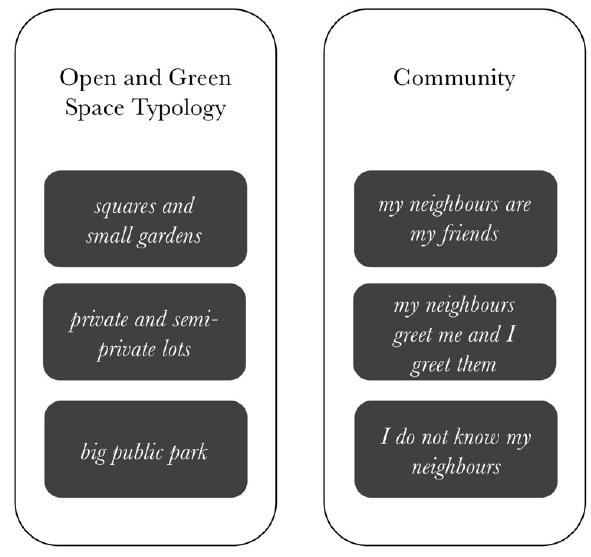
Figure 1. Attributes and levels considered.